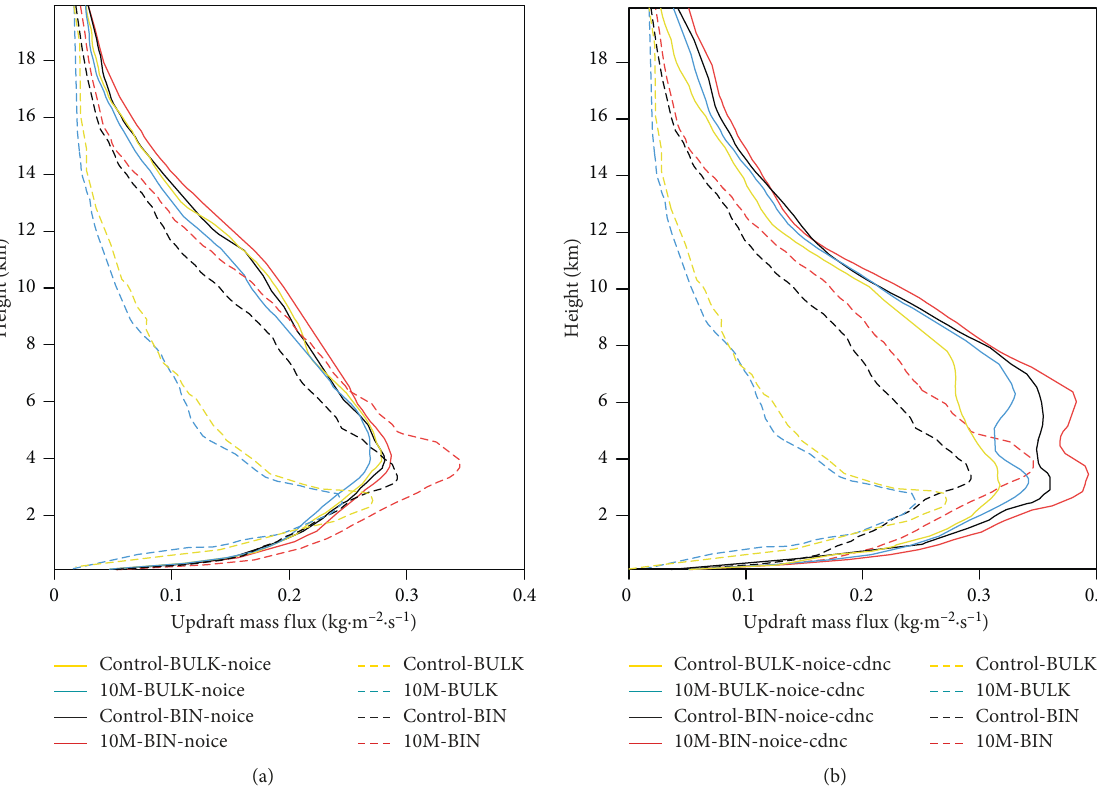
Figure 5: (a) Vertical distributions of the time- and domain-averaged updraft mass fluxes for the standard runs, the control-BULK-noice run, the 10M-BULK-noice run, the control-BIN-noice run, and the 10M-BIN-noice run. (b) Vertical distributions of the time- and domain- averaged updraft mass fluxes for the standard runs, the control-BULK-noice-cdnc run, the 10M-BULK-noice-cdnc run, the control-BIN- noice-cdnc run, and the 10M-BIN-noice-cdnc